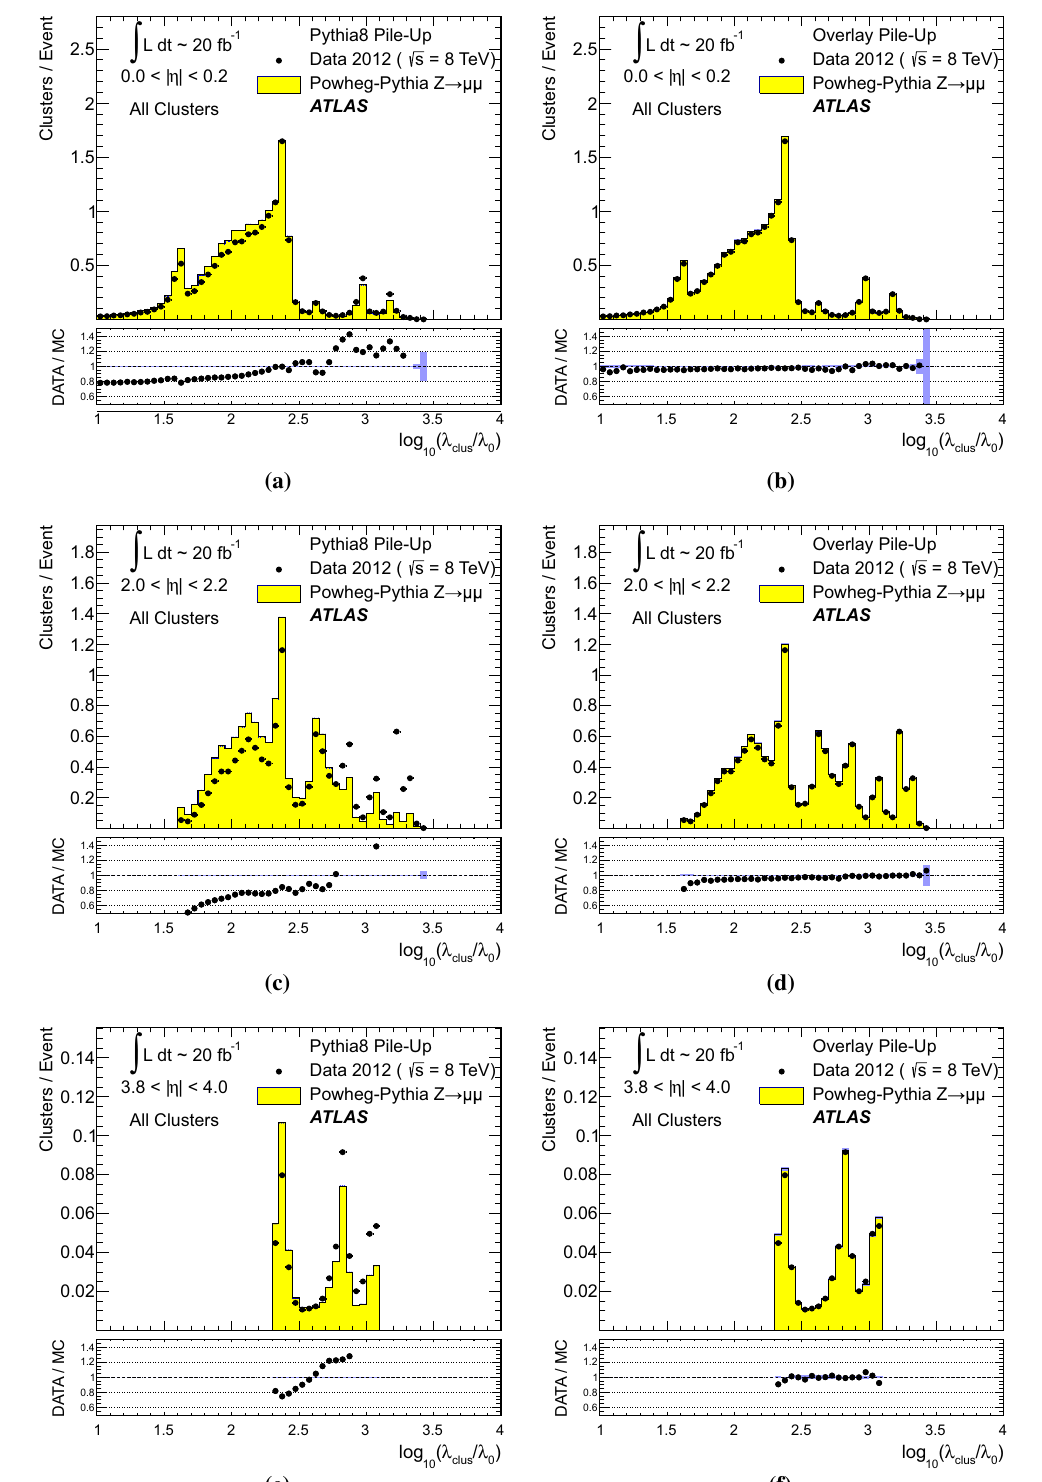
e 3 . 8 < | η clus | < 4 . 0. The corresponding distributions for MC simula- tions with pile-up from data overlaid are depicted in b , d , and f . The ratios of the distributions for data and MC simulations are shown below the respective distributions. The shaded bands indicate the statistical uncertainties for MC